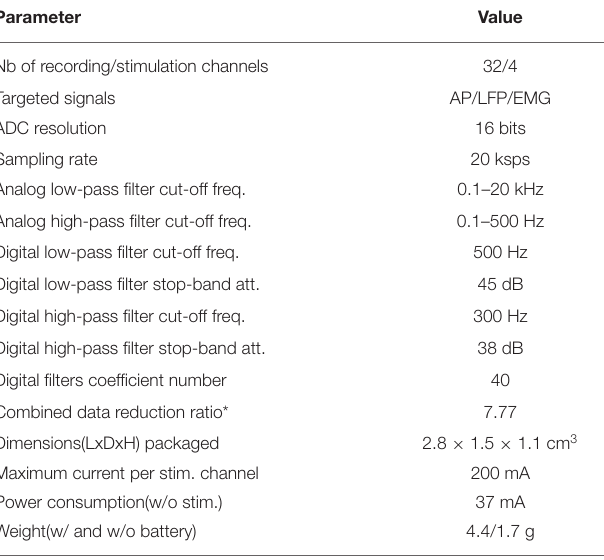
TABLE 1 | Platform’s characteristics and performance.